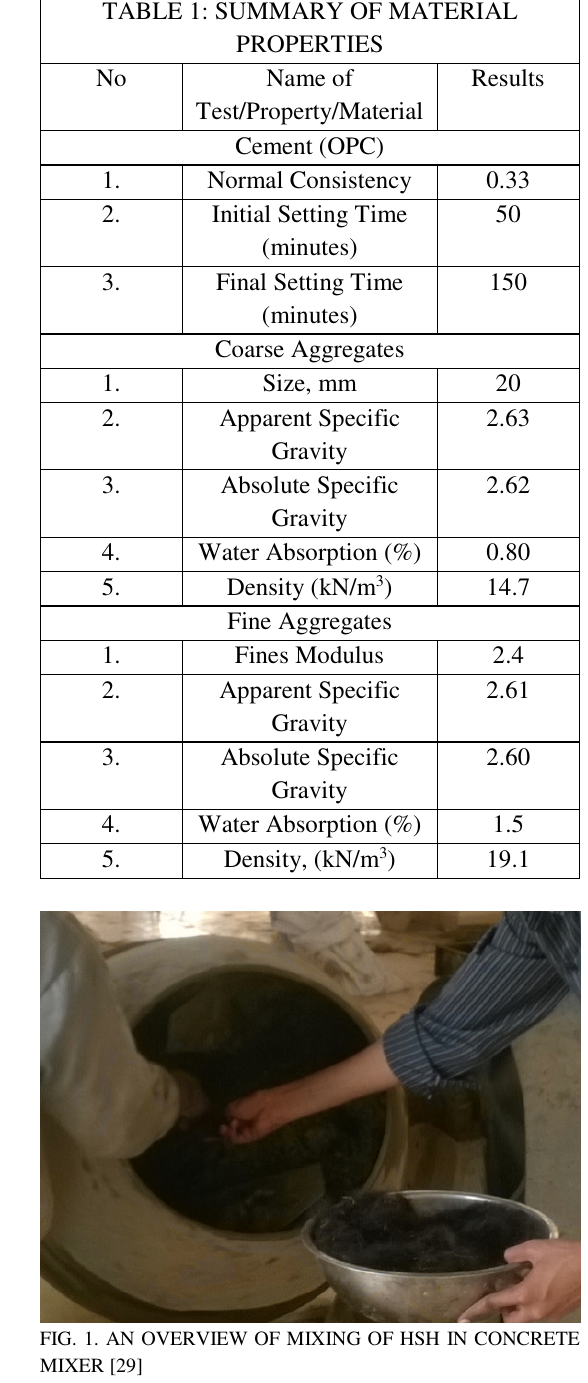
TABLE 1: SUMMARY OF MATERIAL PROPERTIES